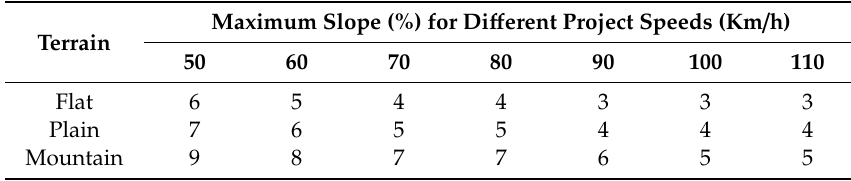
Table 2. Relation between maximum slope, type of terrain and project